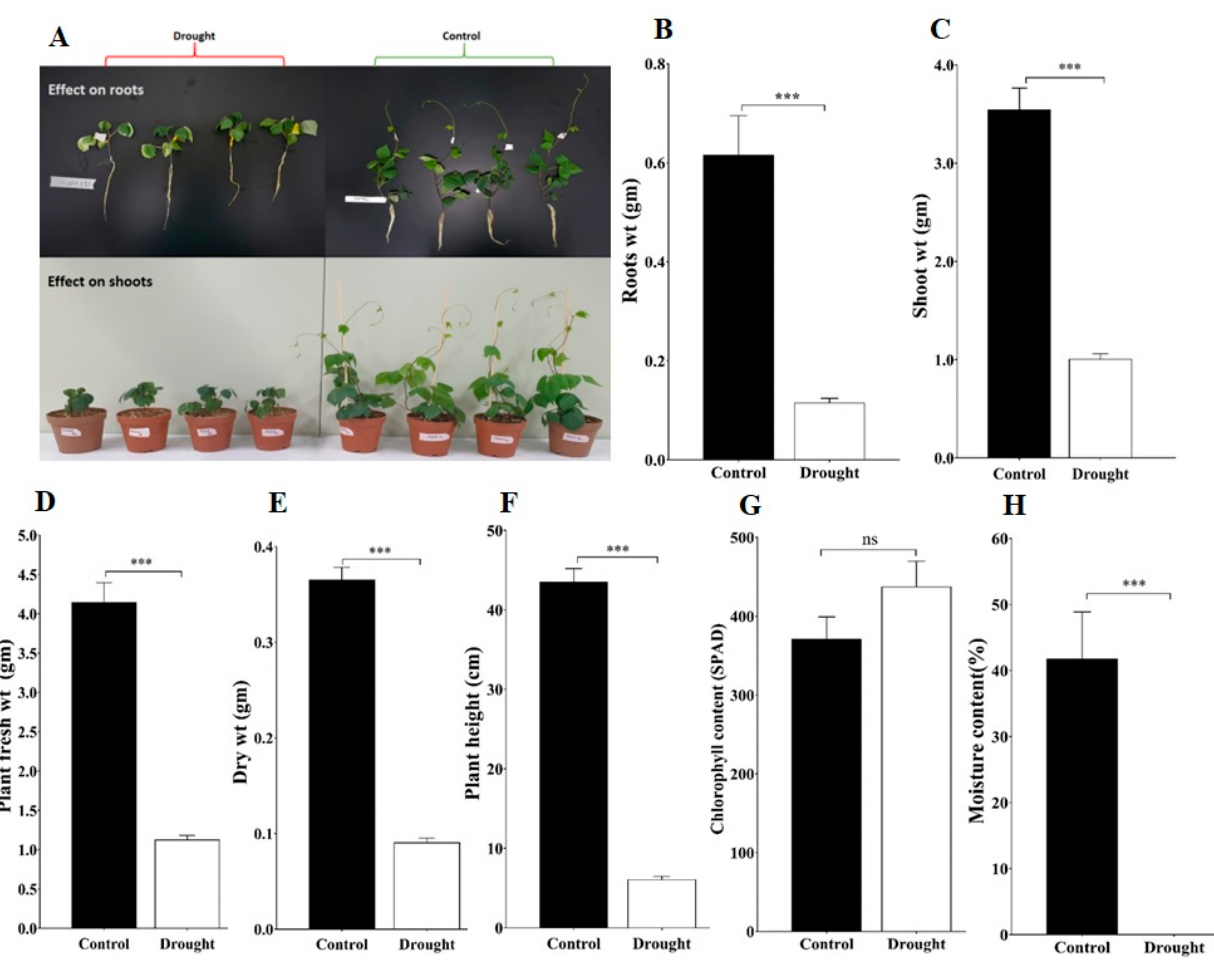
Figure 5. Effects of drought stress on the adzuki bean plants: ( A ) Evaluation of adzuki bean plant under drought and control conditions; ( B ) Plant roots weight; ( C ) Plant shoot weight; ( D ) Plant fresh weight; ( E ) Plant dry weight; ( F ) Plant height; ( G ) Chlorophyll content; and ( H ) Soil moisture content. Under control and drought stress conditions at 10th day of treatment. Data are means ± SD of n = 4 biological replicates. Error bars represent standard deviation. Means were analyzed for significant differences using the Student’s t -test. Asterisks (*) indicate differences at 5% level of significance (*** p < 0.001; ns, nonsignificant.).